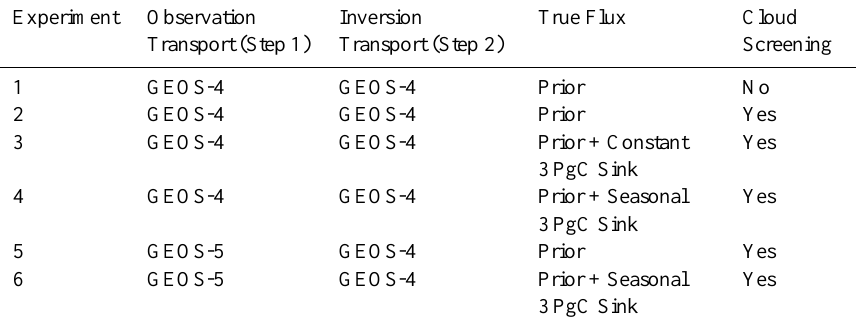
Table 2. Summary of OSSE’s used in source/sink inversions. Red shading refers to “perfect transport” experiments, green “signal detection”, and blue “biased transport”. The “true” flux refers to the set of surface CO 2 fluxes prescribed in Step 1. The “prior” flux refers to surface fluxes used as a first guess in Step 2. Prior fluxes are described in Parazoo et al. (2008), and include a steady state terrestrial biosphere. This means that the true flux in Experiments 1, 2 and 5 is the same as the prior flux used in Step 2, while the true flux in Experiments 3, 4 and 6 also includes a globally distributed 3PgC sink (see Fig.